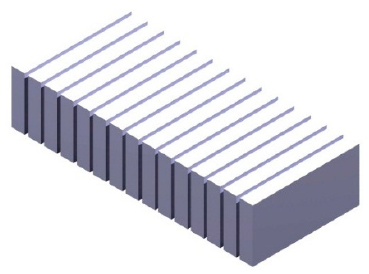
Figure 5. Battery module.